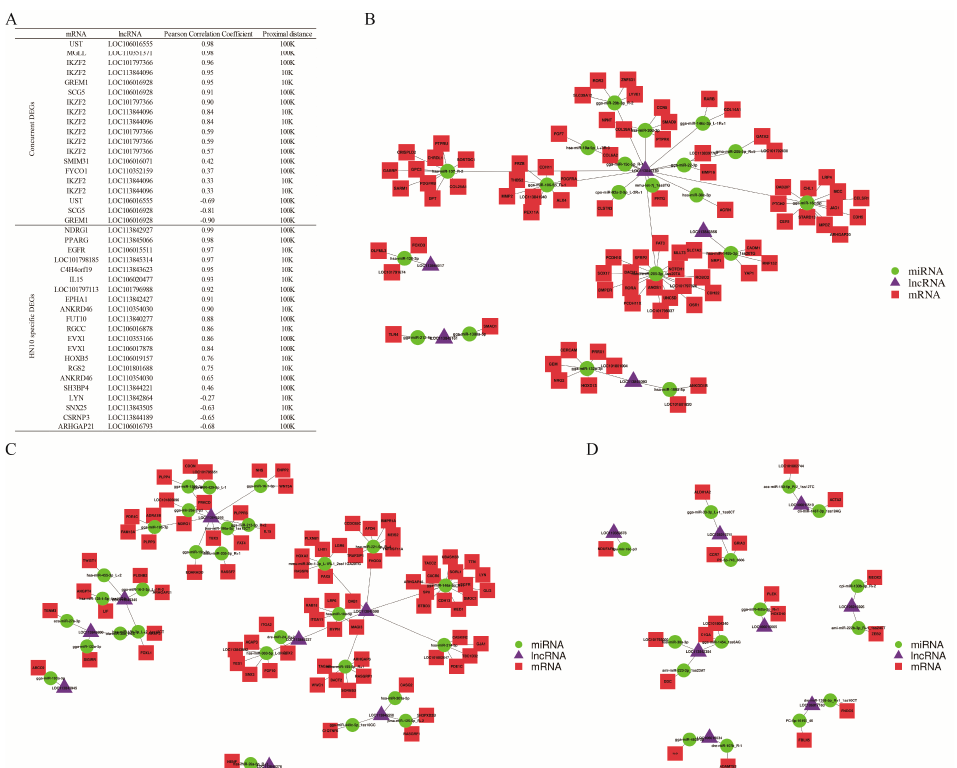
Figure 4. Network of differential expressed mRNA, lncRNA and miRNA in HN10 and JDm10 induced the bursa of Fabricius. ( A ) This table showed the interaction between differential expressed mRNA and lncRNA through the cis-regulatory module. ( B – D ) Network showed the interaction among differential expressed mRNA, lncRNA and miRNA special in HN10 ( B ) and JDm10 ( C ) as well as mutual in HN10 and JDm10 ( D ) through ceRNA modules.